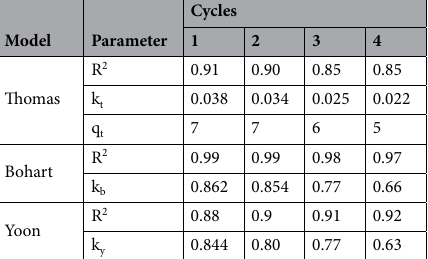
Table 8. Summary of the experiments obtained with material EC-Na in process of desorption’s.